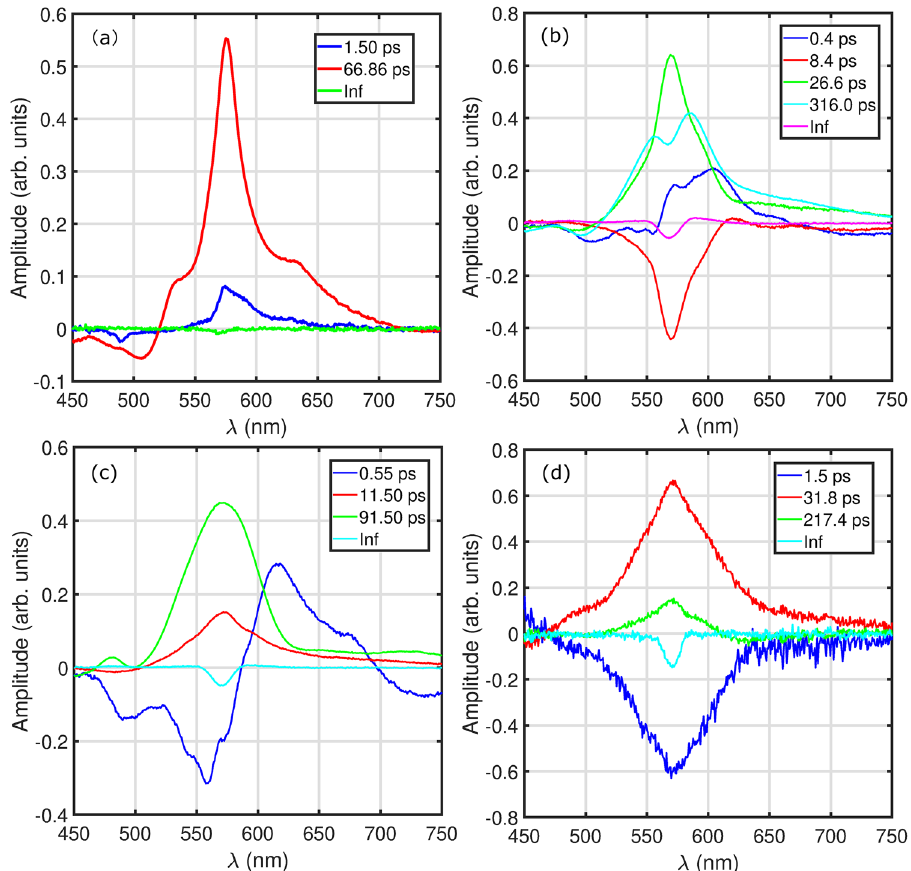
Figure 3. Analysis of TA data. Decay-associated spectra obtained from TA data of HB194 in different solvents: ( a ) CYH, ( b ) DCM, ( c ) DMK and ( d )